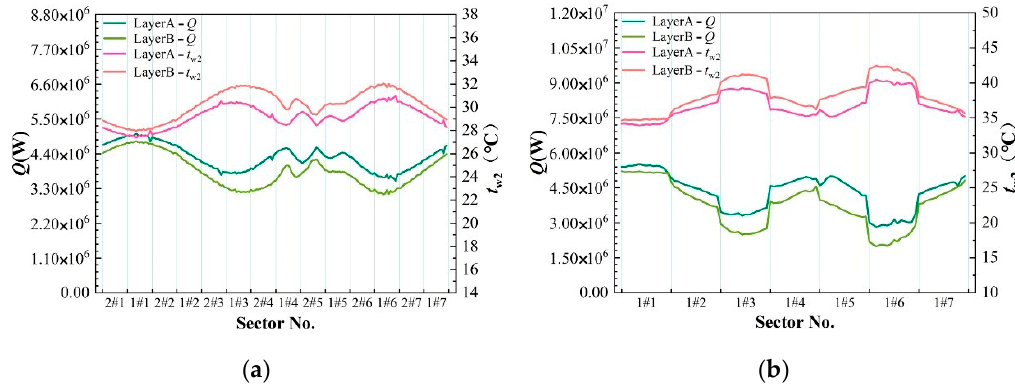
Figure 7. Heat rejections and water outlet temperatures of double-layer cooling deltas under a typical crosswind of 4 m/s. ( a ) In the case of 2 units; ( b ) in the case of 1 unit.